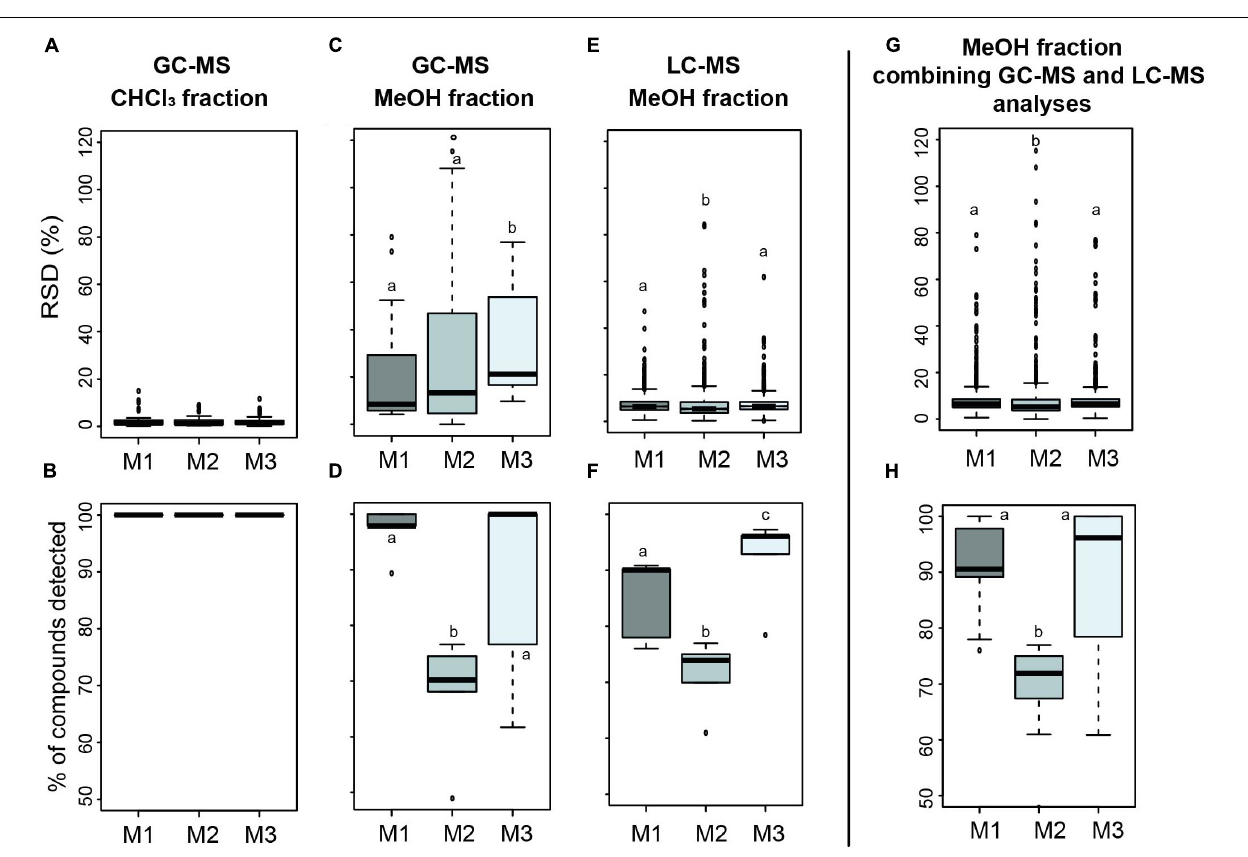
( Figure 4A ). The supervised analysis (PPLS-DA) highlighted the influence of time and light exposure on the metabolome of the MPB biofilm. Indeed, different metabolomic